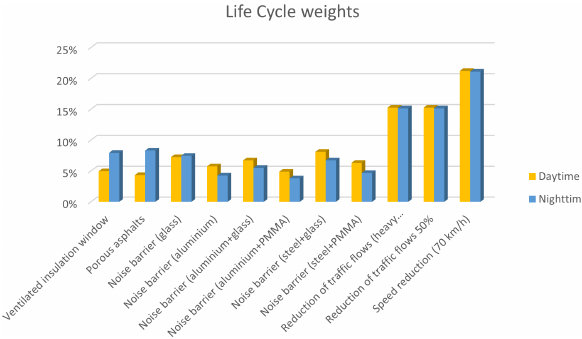
Figure 9: Comparison of life cycle weights in the two scenarios